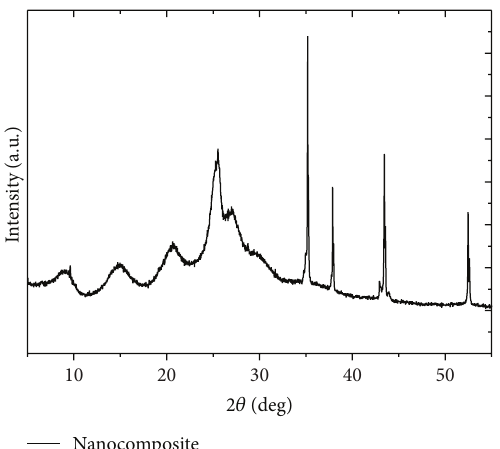
Figure 2: Nanocomposite X-ray diffraction pattern.